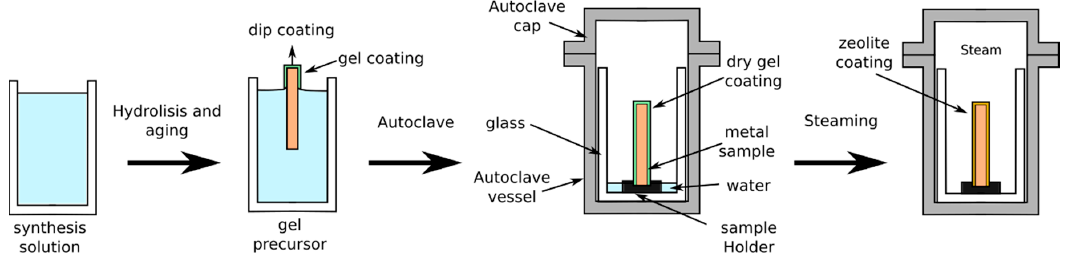
Figure 4. Scheme of dry-gel conversion synthesis process.